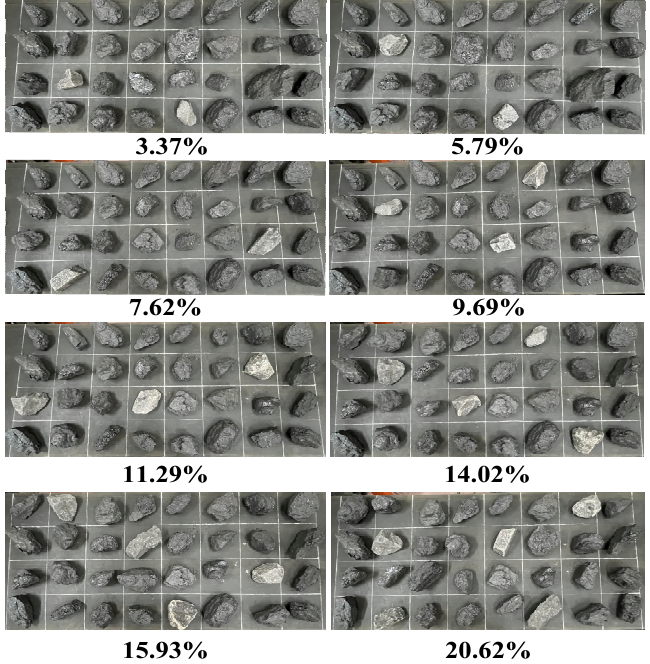
Figure 16. Placement diagram of samples with different gangue rates.